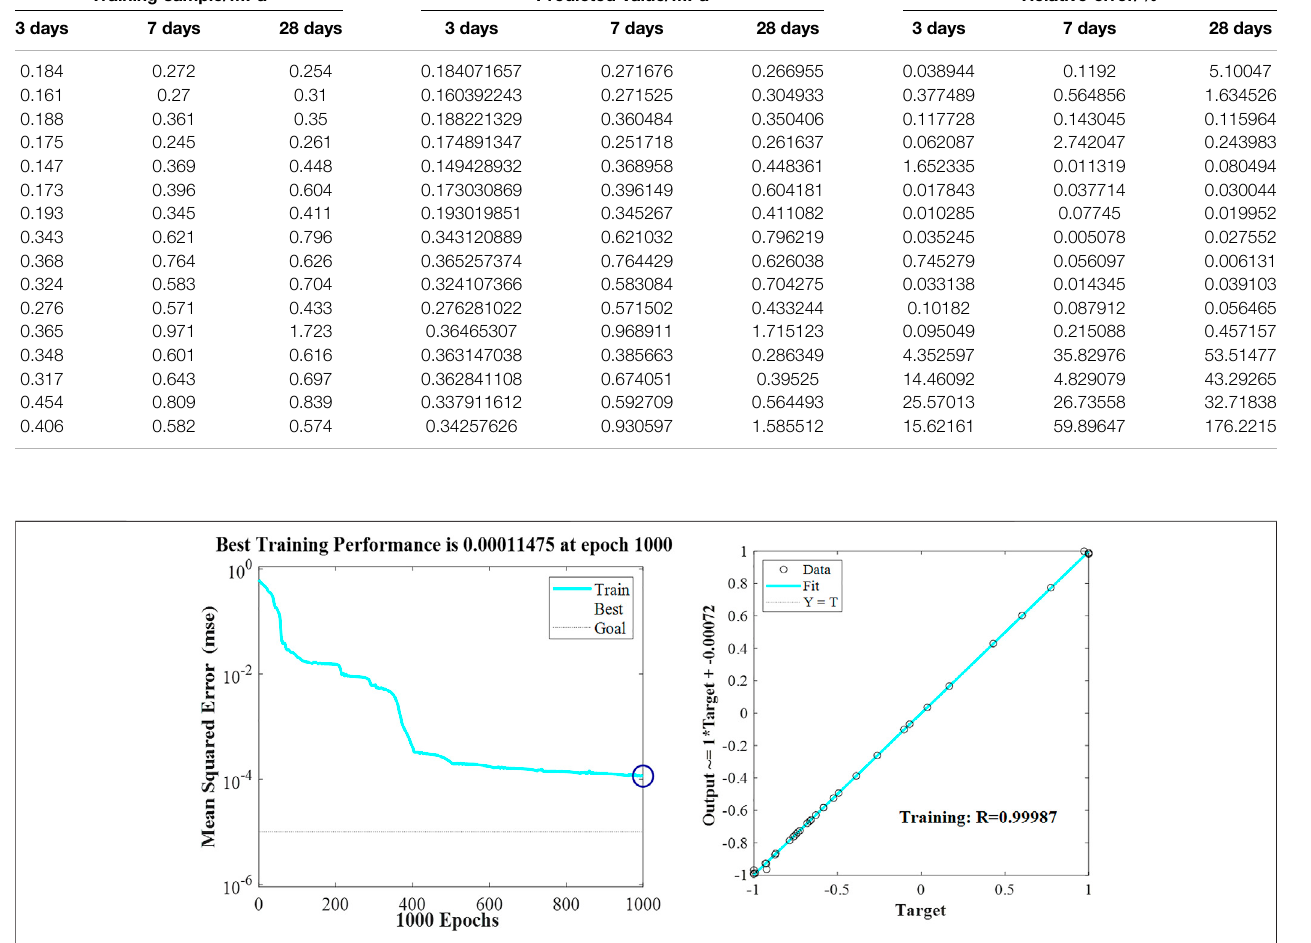
TABLE 4 | Predicted values and relative error results of strength at different curing ages. Training sample/MPa